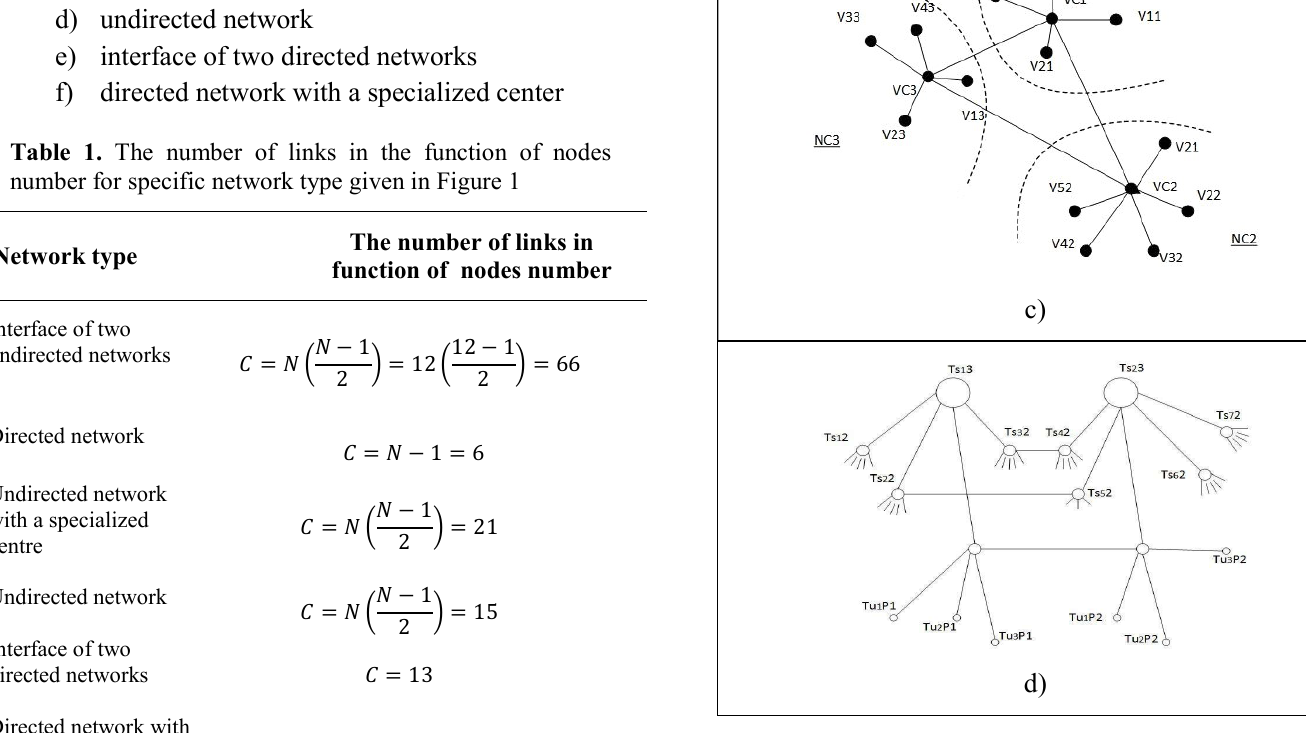
Figure 2. Network classification according to